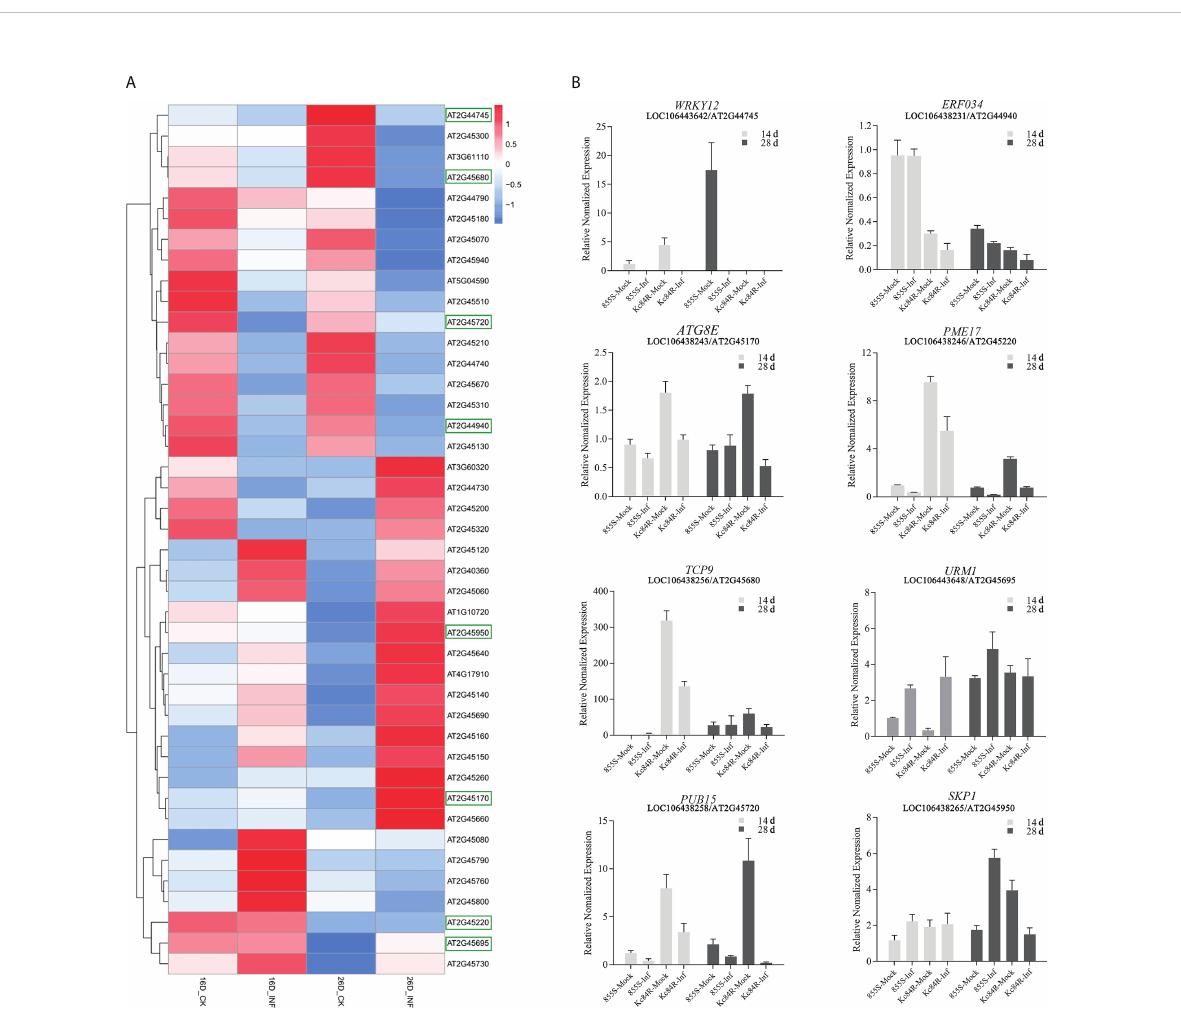
FIGURE 4 Expression patterns of candidate genes. (A) Expression patterns of candidate genes of homologous in A. thaliana roots in response to P. brassicae , INF indicates the treatment with P. brassicae , CK indicates the treatment with sterile water, the boxes indicate genes selected for quanti fi cation in B. napus ; (B) transcript levels of selected candidate genes at 14- and 28-days post inoculation (dpi) in B. napus Kc84R and 855S. The inoculation with P. brassicae was taken as treatment group (Inf) and sterile water as blank control